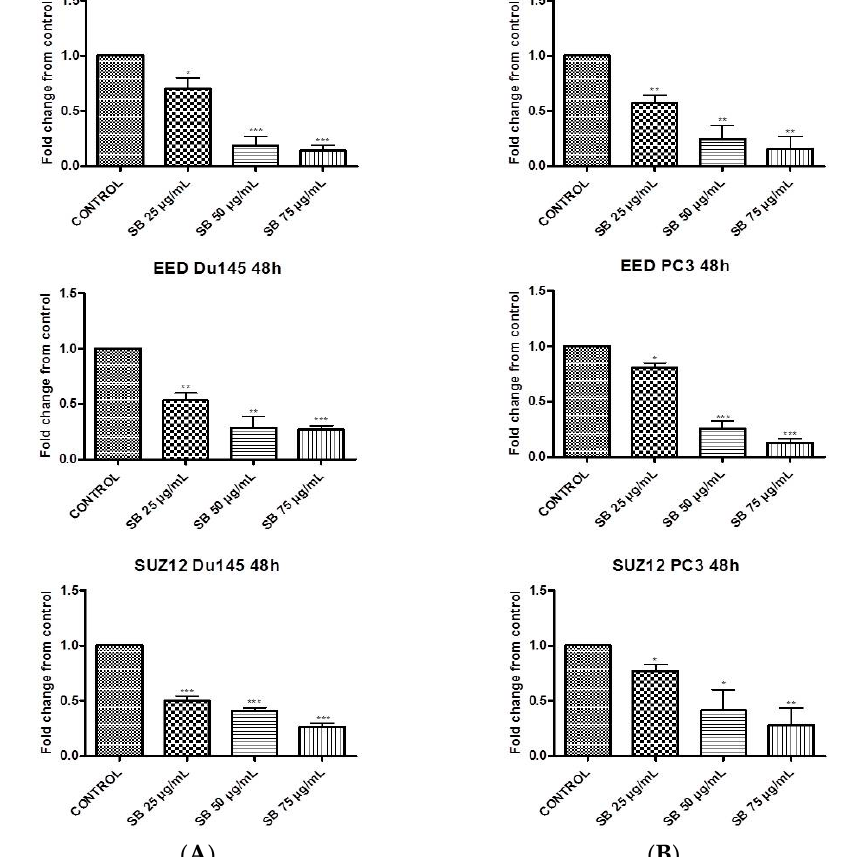
Figure 1. Silibinin suppresses the expression of Polycomb Repressive Complex 2 (PRC2) complex members. DU145 ( A ) and PC3 ( B ) cells were incubated for 48h with different concentrations of silibinin (25–75 μ g/mL). After treatments, cells were harvested for Real Time Polymerase Chain Reaction (RT-PCR) analysis of Enhancer of Zeste Homolog 2 ( EZH2 ), Suppressor of Zeste Homolog 12 ( SUZ12 ) and Embryonic Ectoderm Development ( EED ) genes. The expression levels of target genes were normalized to β -actin (internal control). The results are presented as mean ± SD of three independent experiments. * p < 0.05; ** p < 0.01; *** p < 0.001.